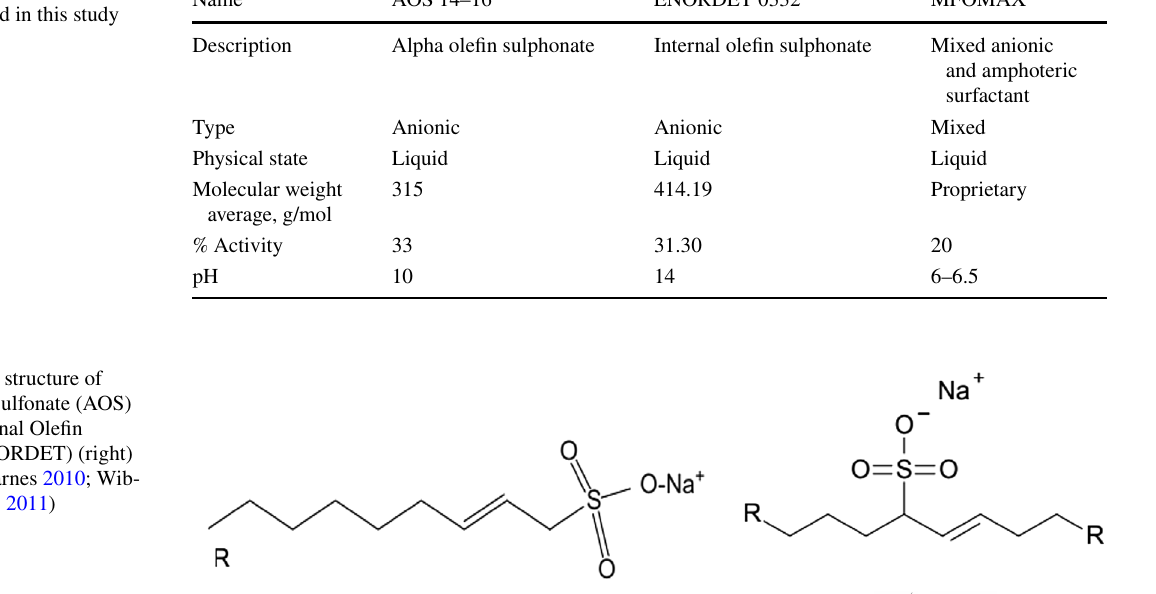
Table 2 Properties of surfactants used in this study